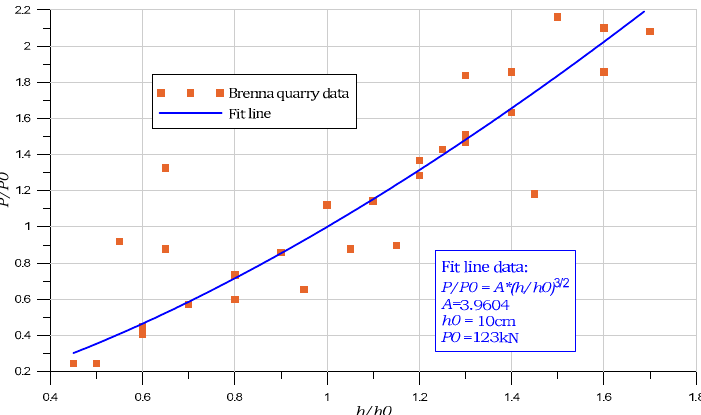
Figure 13. Results of tests for pulling out the anchor fixed in the rock mass of the "Brenna" sandstone. Relationship between maximum force and anchorage depth with exponential fit line.